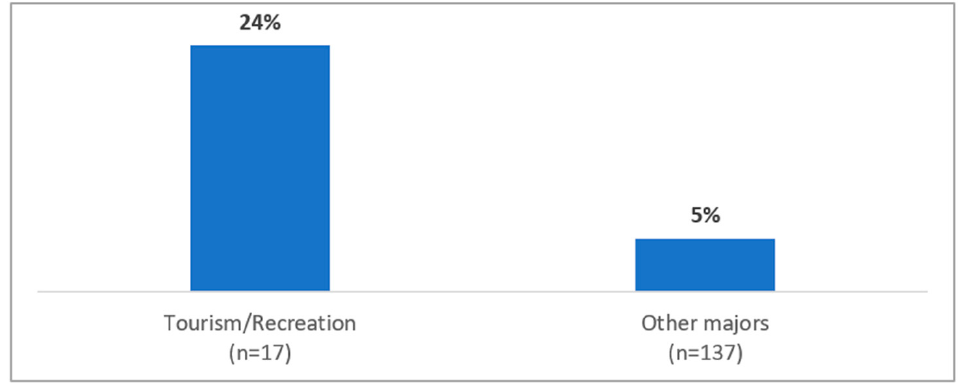
Figure 13. Help finding employment by type of major.